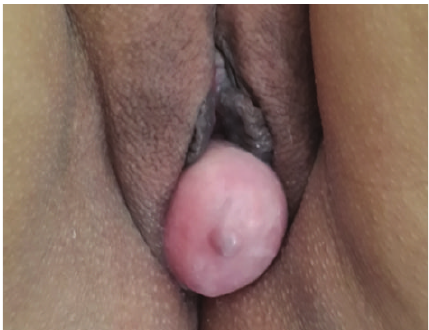
Figure 1: A pelvic examination revealed a mass of the anterior wall of the vagina measuring 8 cm in diameter.